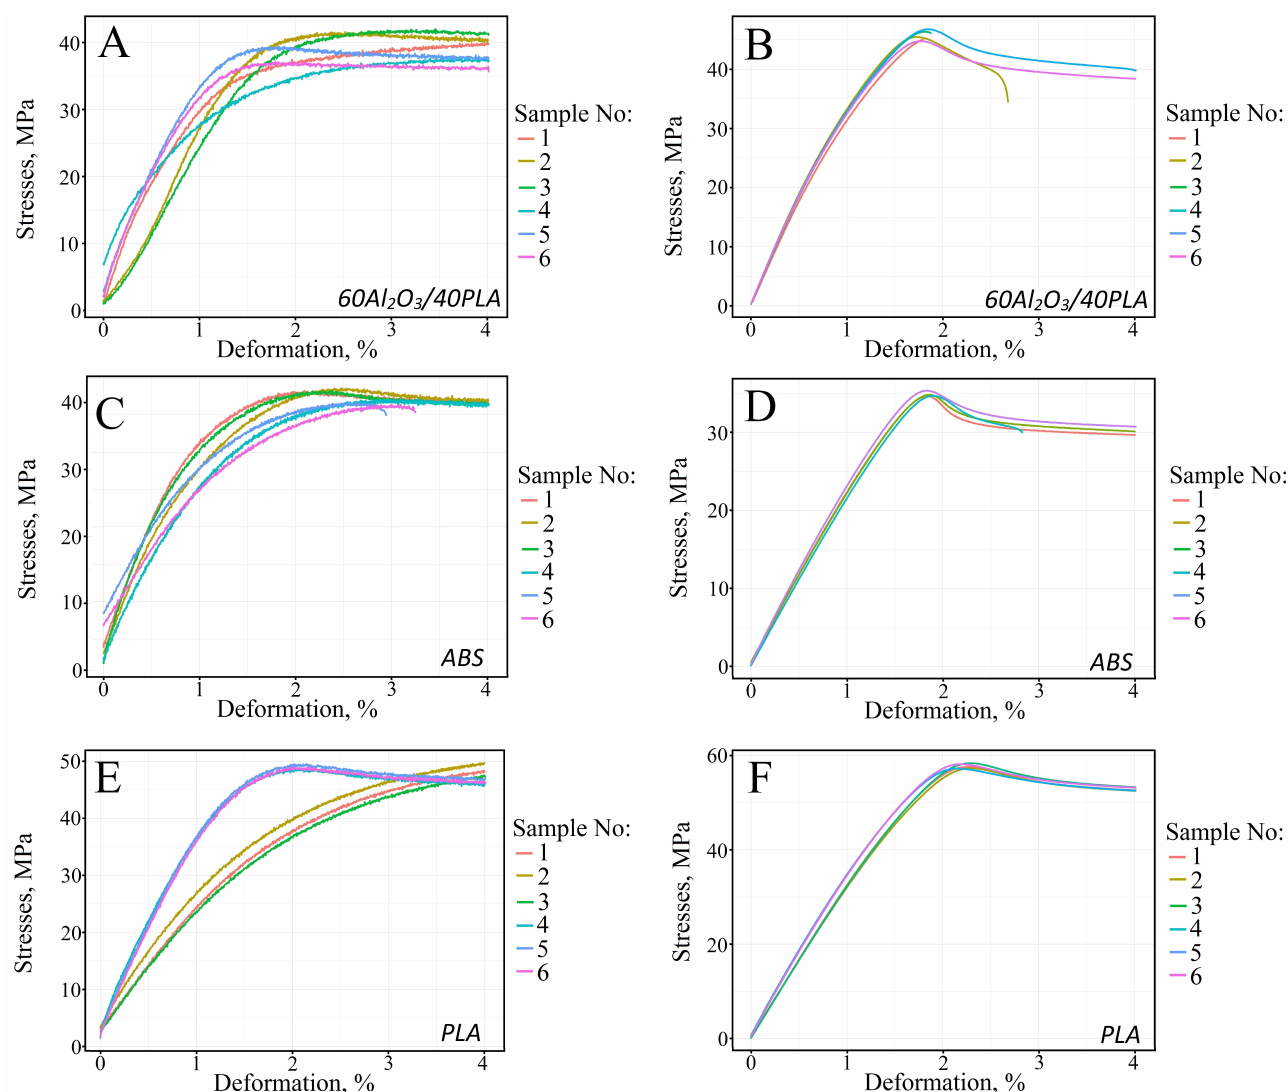
Figure 2. Tensile static curves for filaments ( A , C , E ) and printed ( B , D , F )